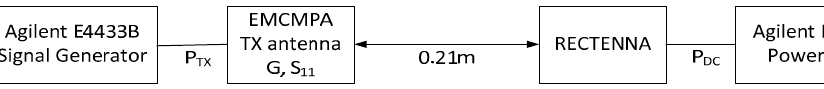
Figure 12. PCE measurement test setup.